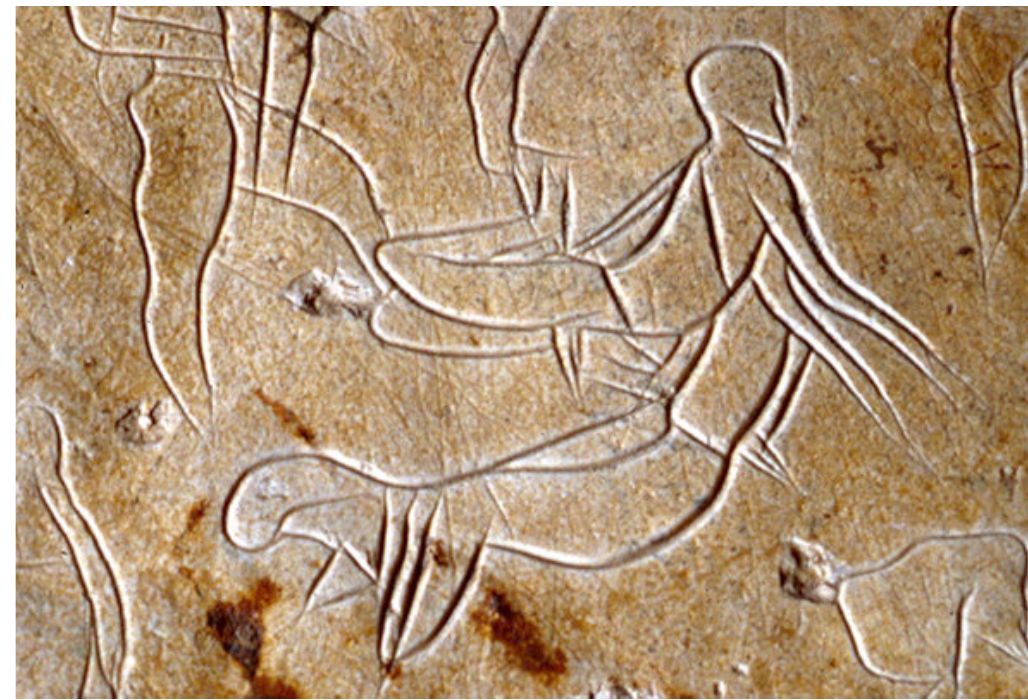
Figure 2. Addaura cave, part